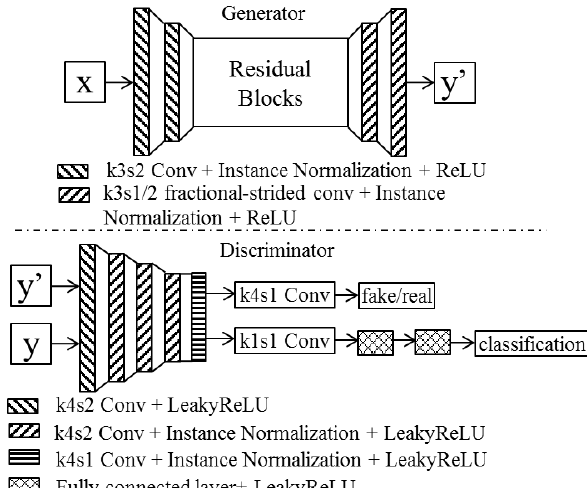
Figure 5. Details of Network Architecture. Conv